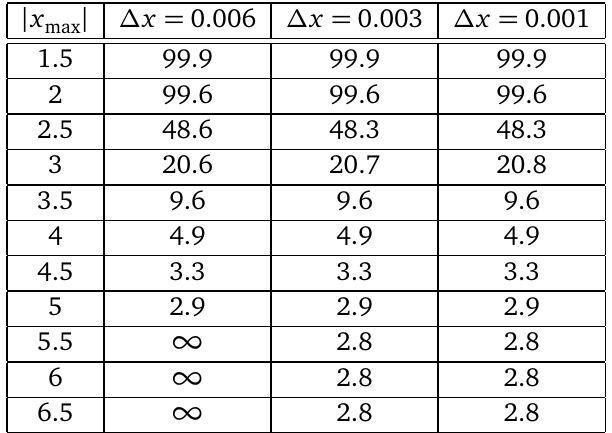
Table 2: Testing the convergence of the numerical approximation for the initial wave function ∝ x 2 e − x 2 / 5 and parameters α = 1 and t = 2 at n = 200. We provide